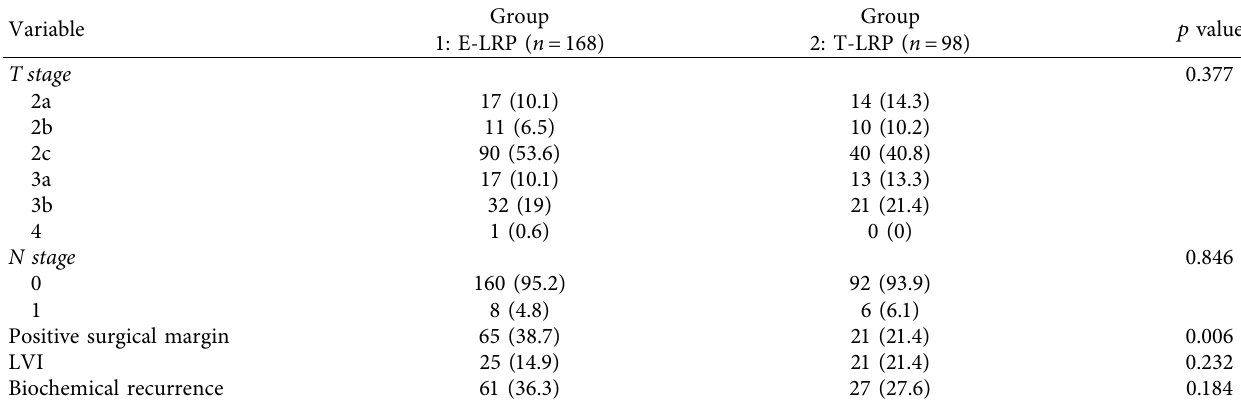
Table 4: Postoperative pathologic data.